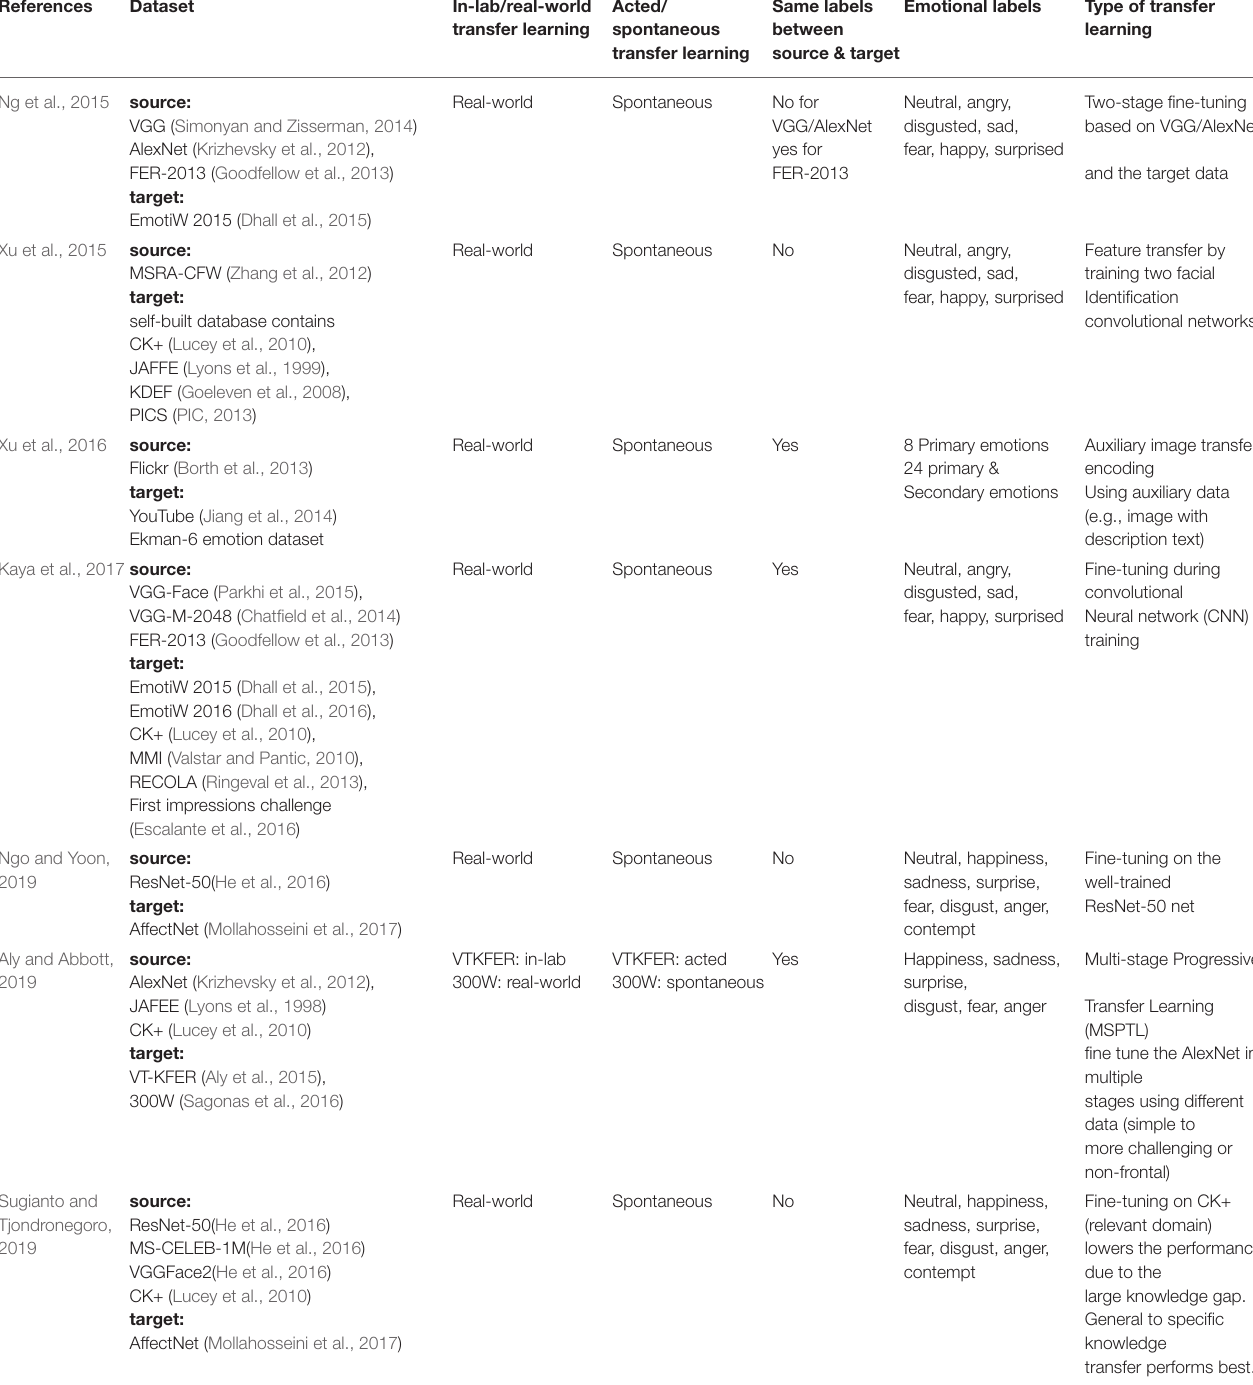
TABLE 2 | Overview of the previous work on transfer learning for video/image-based emotion